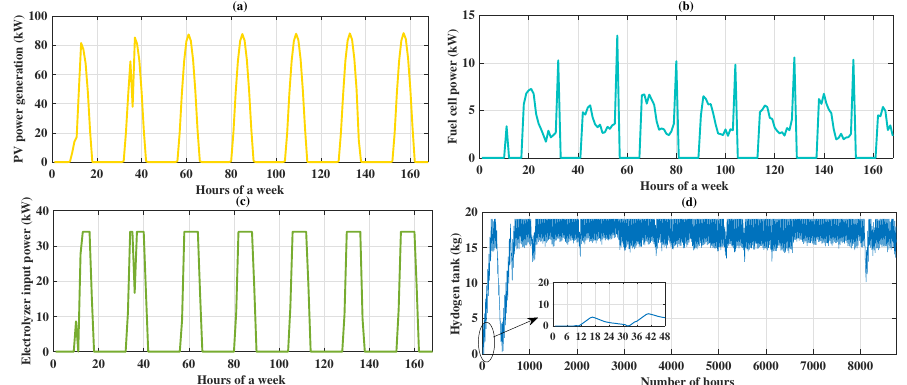
Figure 5. ( a ) Power generated by PV panels in one week; ( b ) fuel cell power generation in one week; ( c ) electrolyzer input power in one week; ( d ) hydrogen tank storage status throughout the